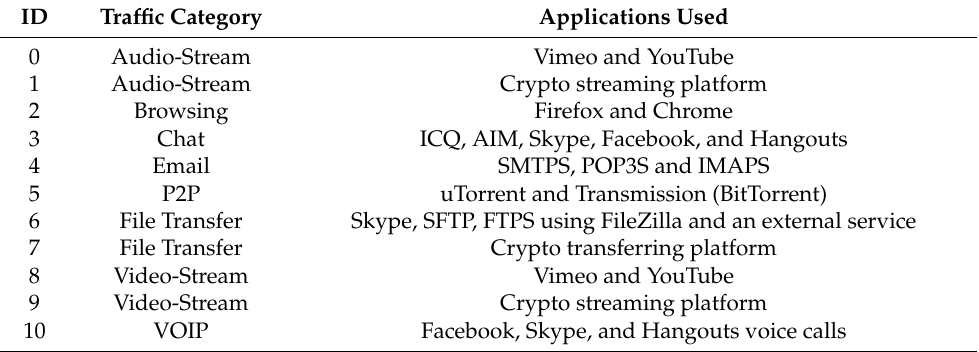
Table 1. Darknet network traffic